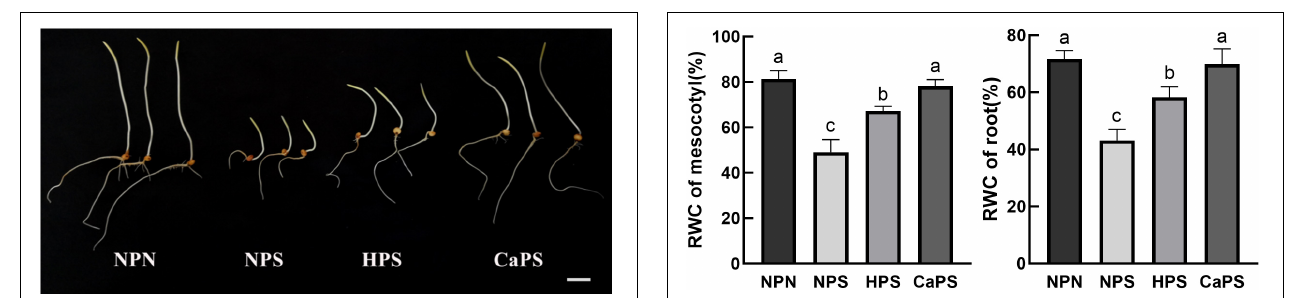
Accumulation of Osmotic Adjustment Substance Under salt stress, the content of soluble sugar, proline, free amino acid, and soluble protein in mesocotyl were significantly increased by 72.21, 60.50, 21.13, and 15.05%, respectively ( Figure 3 ). The content of soluble sugar, proline, free amino acid, and soluble protein in root, respectively, increased 42.26, 68.79, 22.53, and 39.30%. Compared with NPS treatment, the soluble sugar, proline, free amino acid, and soluble protein content in mesocotyl were significantly increased by 22.21,